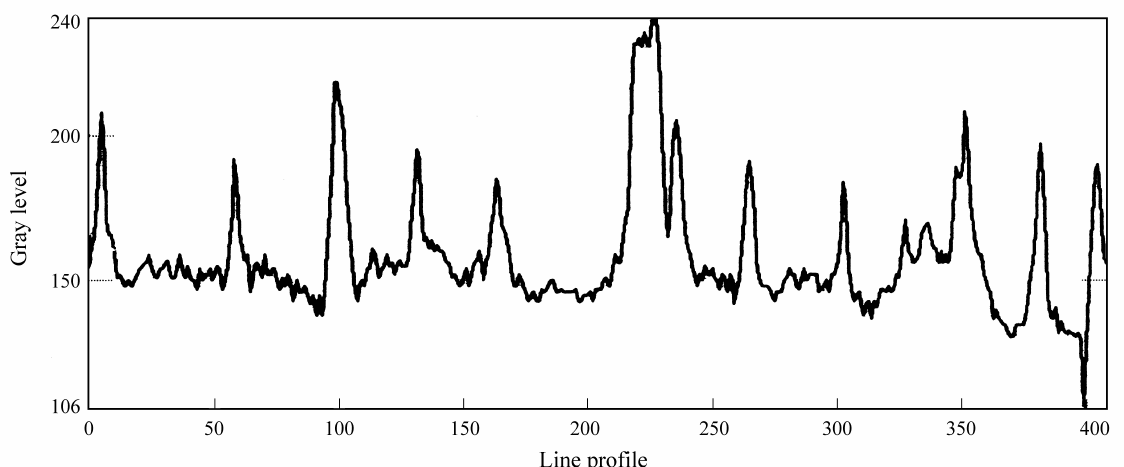
Figure 4. Arbitrary line profile of the uranium oxide micrograph showed in Fig. 1. The spaces between two relatively high peaks represent catchment basins, i.e. , grains. The small peaks inside the catchment basins are due to noise introduced during the image acquisition